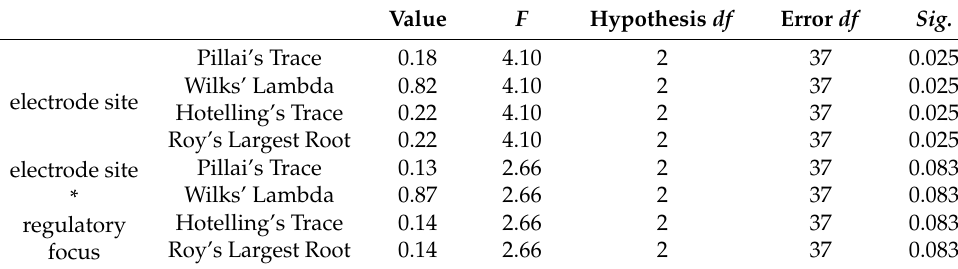
Table 10. Multivariate tests of P2 amplitude (regulatory